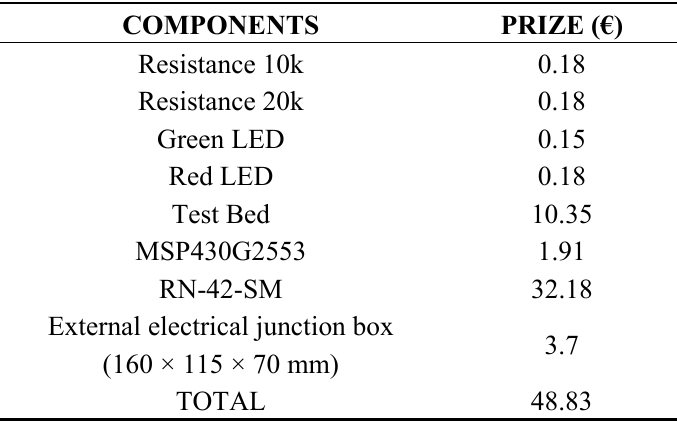
Table 3. Parts used and total cost of the